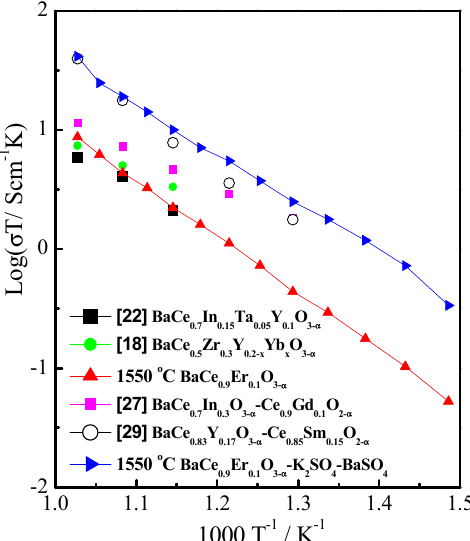
Figure 5. The conductivities of BaCe 0.9 Er 0.1 O 3 −α (1550 °C) and BaCe 0.9 Er 0.1 O 3 −α –K 2 SO 4 –BaSO 4 in nitrogen from 400 to 700 °C.